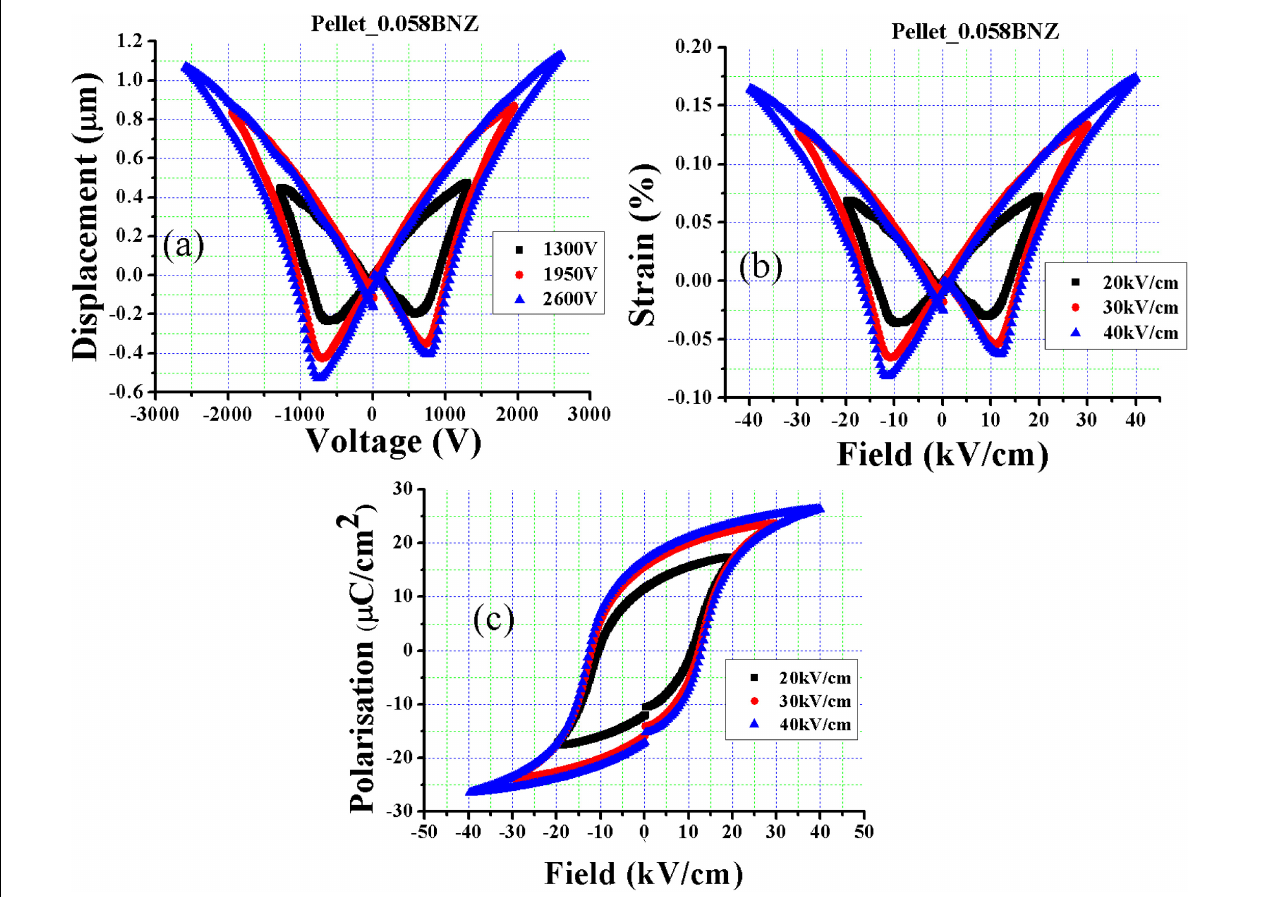
FIGURE 7 | (a) Strain-Voltage, (b) Strain-Field, and (c) Polarization-Field Hysteresis loops of pellet sample (0.942KNN-0.058BNZ); measured at Sheffield Hallam University.